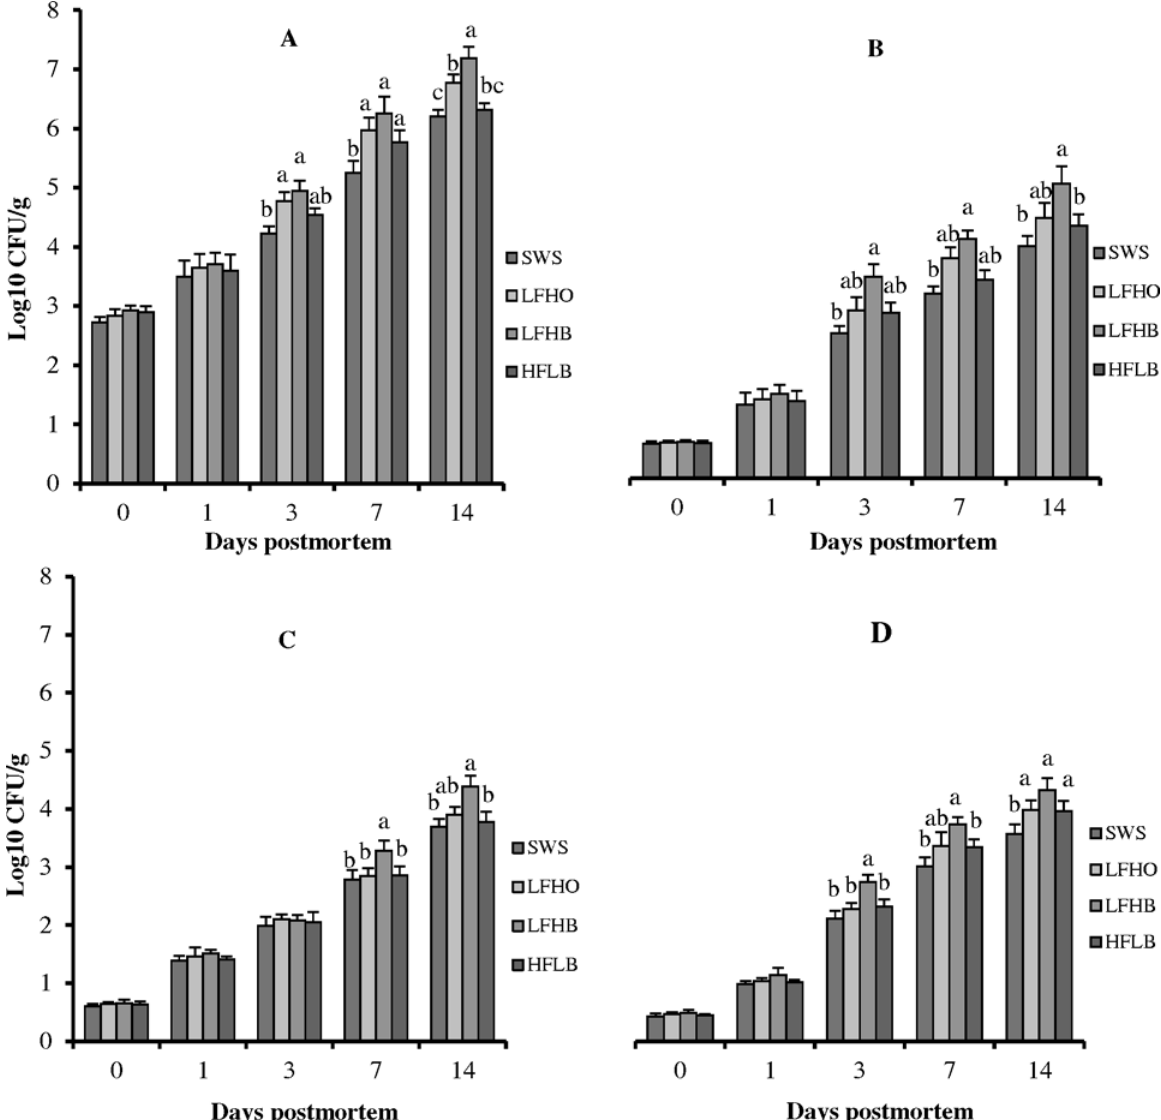
Fig 4. Microbiological quality during postmortem aging periods of semitendinosus muscle in goat subjected to slaughter without stunning and slaughter following different methods of electrical stunning. Graphs A-D: the population of total aerobic counts, Pseudomonas spp., lactic acid bacteria and Enterobacteriaceae , respectively. SWS: slaughter without stunning, LFHO: low frequency head-only, electrical stunning, LFHB: low frequency head-to- back electrical stunning, HFHB: high frequency head-to-back electrical stunning. Values within day with different superscripts differ significantly at p < 0.05. Values are means ± 1 standard error (n =